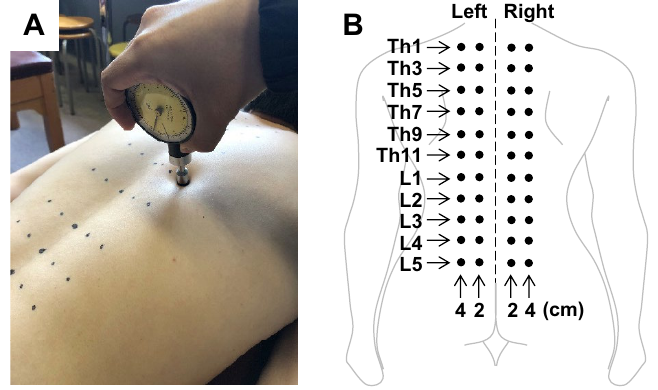
Figure 1. Measurement of pressure pain threshold in thoracolumbar paraspinal muscles. ( A ) Pressure algometry using a pressure algometer, having a flat and circular rubber tip with a surface of 1 cm 2 . ( B ) The measurement points. Bilateral paraspinal muscles of the thoracolumbar area (2 and 4 cm apart from midline at spinal segments Th1, Th3, Th5, Th7, Th9, Th11, L1, L2, L3, L4, and L5, i.e. 4 points × 11 segments = 44 points) were randomly tested to cancel order effect.